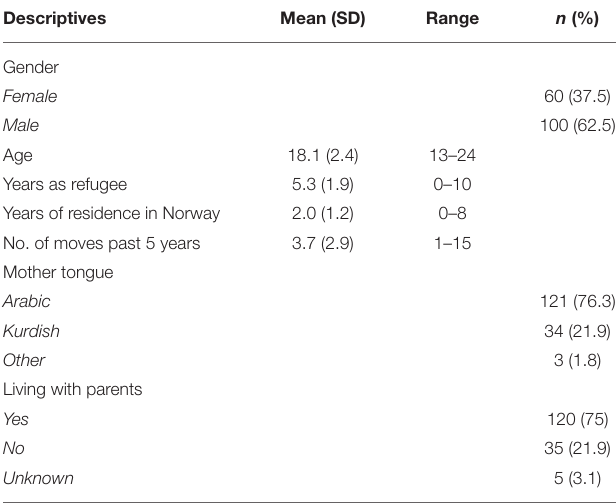
TABLE 1 | Sociodemographics of the participants ( n = 160).